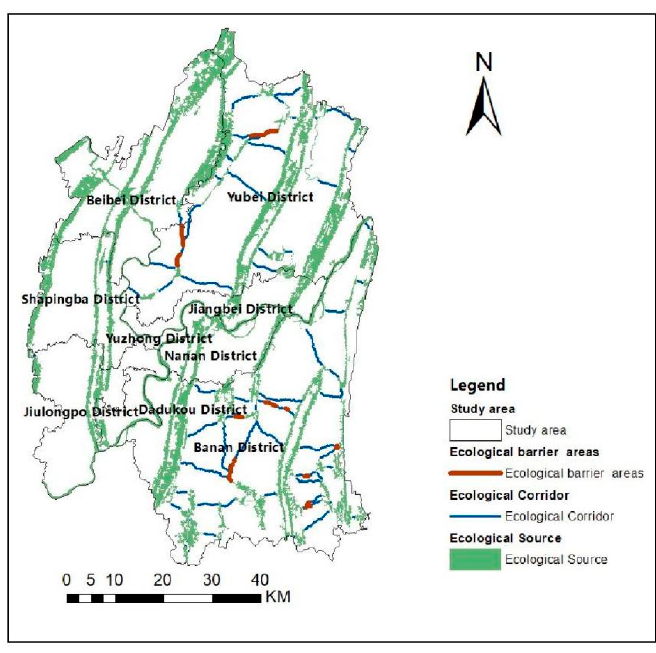
Figure 9. Distribution of ecological barrier points.